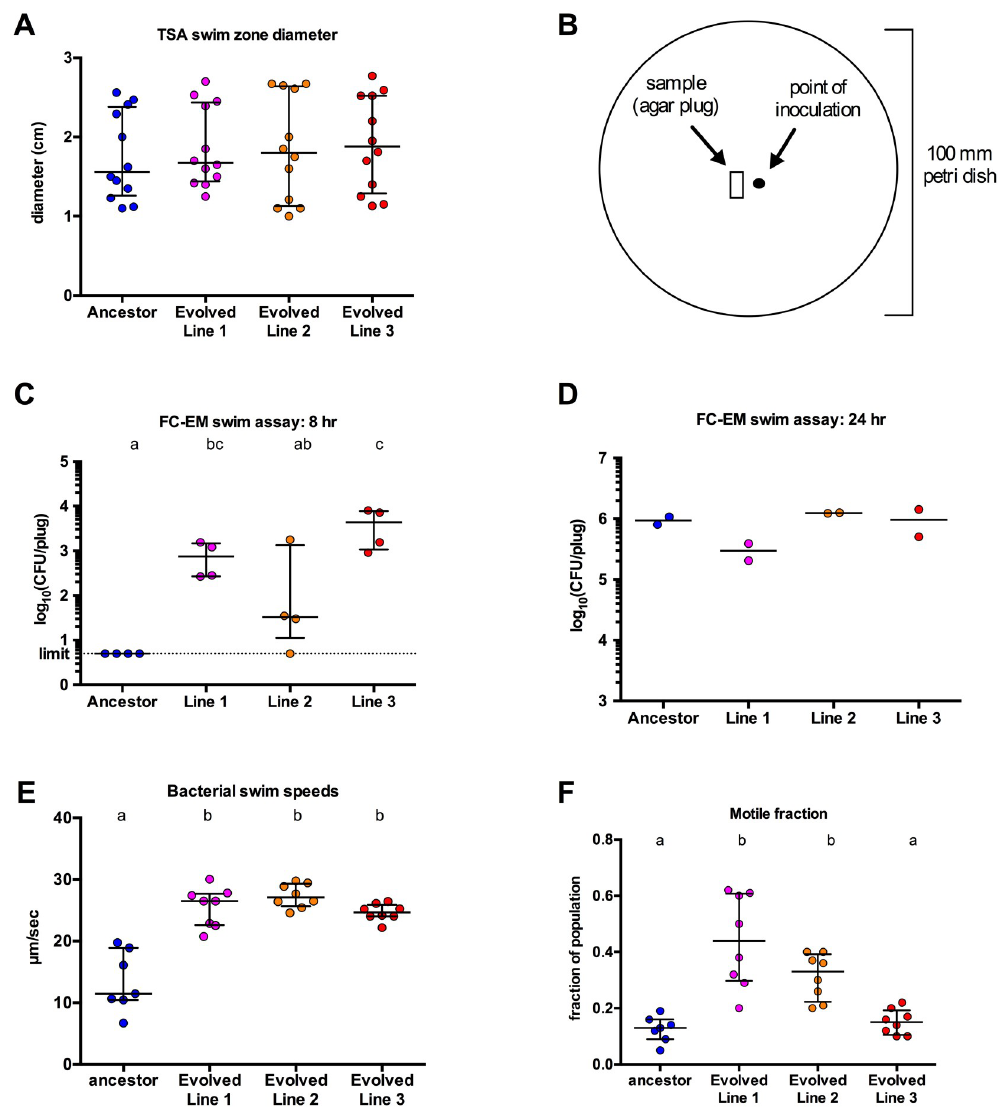
Fig 5. Evolved isolates demonstrate increased motility compared to the ancestor. (A) Diameter of swim zones at 8 hours post inoculation for swim plate assay in rich media (TSA). (B) Template for FC-EM swim plate inoculation and sampling; the black dot is the point of inoculation; the small rectangle represents the site of sampling via gel extractor tool. (C and D) Abundance of strains in samples from FC-EM swim plate assays; motility was assessed by sampling an agar plug and enumerating migrated cells via plating at 8 hours (C) or 24 hours (D). (E and F) Bacterial swim speeds (E) and motile fraction of the population (F) were measured directly via live imaging; each data point is representative of an individual movie in which an average of 6,000 (minimum of 2,300) bacterial cells were tracked. Median and interquartile ranges are plotted for all data. Conditions that share a letter are not statistically different (ANOVA, log-transformed data for C). Data combined from two independent experiments for all assays. Underlying data for A–F are provided in S1 Data. CFU/gut, colony-forming unit per gut; FC-EM, fish-conditioned embryo medium; TSA, tryptic soy agar.